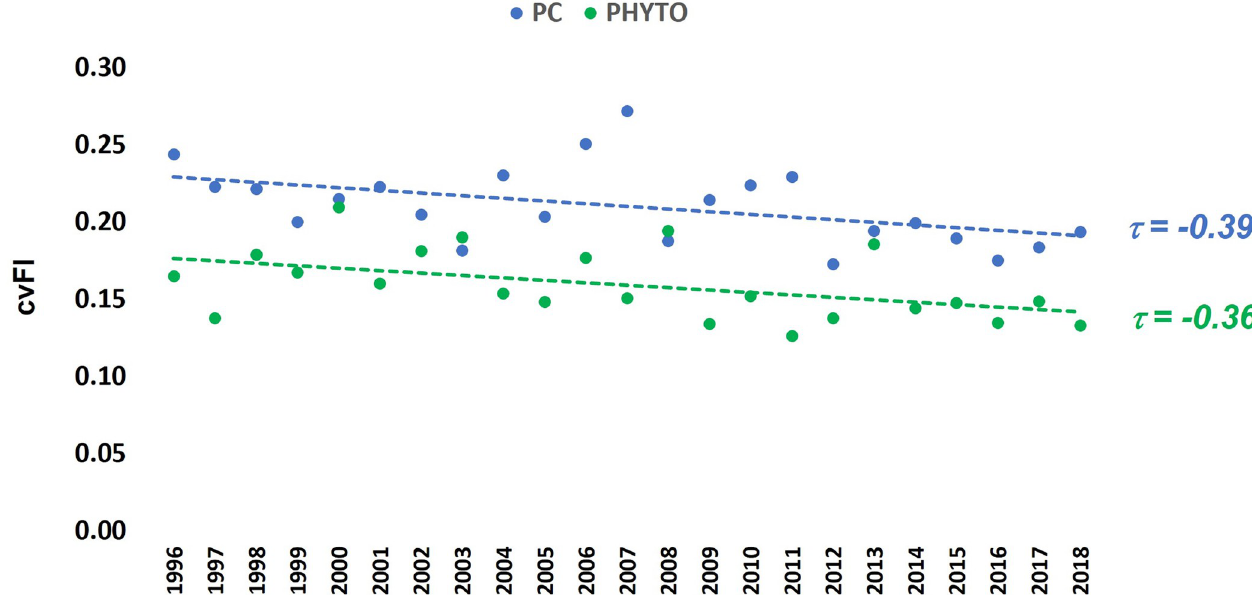
Fig 7. Spatiotemporal variation of the PC and PHYTO dynamics. The cvFI serves as a measure of variation around the mean; hence, lower cvFI values indicate increasing stability. The statistically significant Kendall’s tau correlation values (p-value < 0.05) show the strength of the trend.